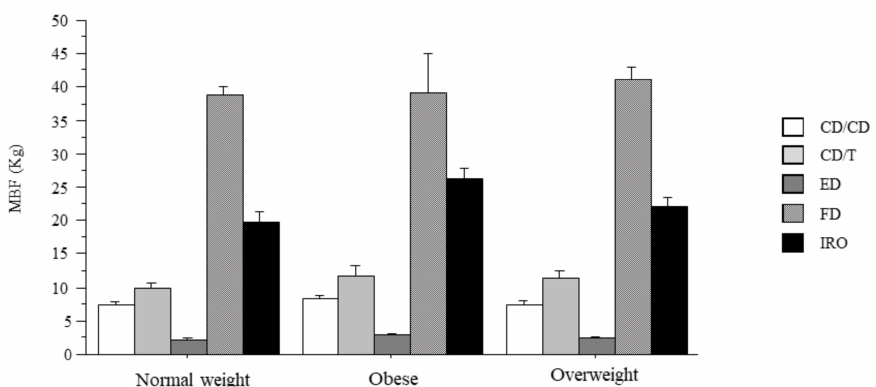
Figure 2. Bite force and body mass index (BMI). Maximal bite force according to body mass index classification. MBF: maximal bite force; subjects with natural full dentition (FD); subjects wearing implant-retained overdentures (IRO); subjects with natural teeth in one arch and wearing traditional complete dentures (CD) in opposite dental arch (CD/T); subjects wearing CD in both arches (CD/CD); edentulous patients in both arches (ED). Data are the mean ±